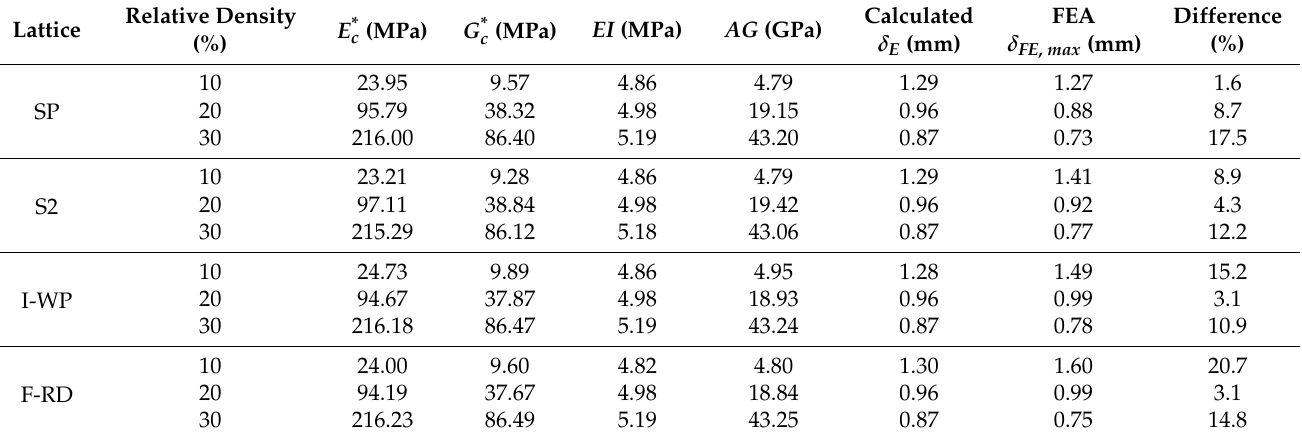
Table 6. Differences between the calculated weight and numerical prediction for each